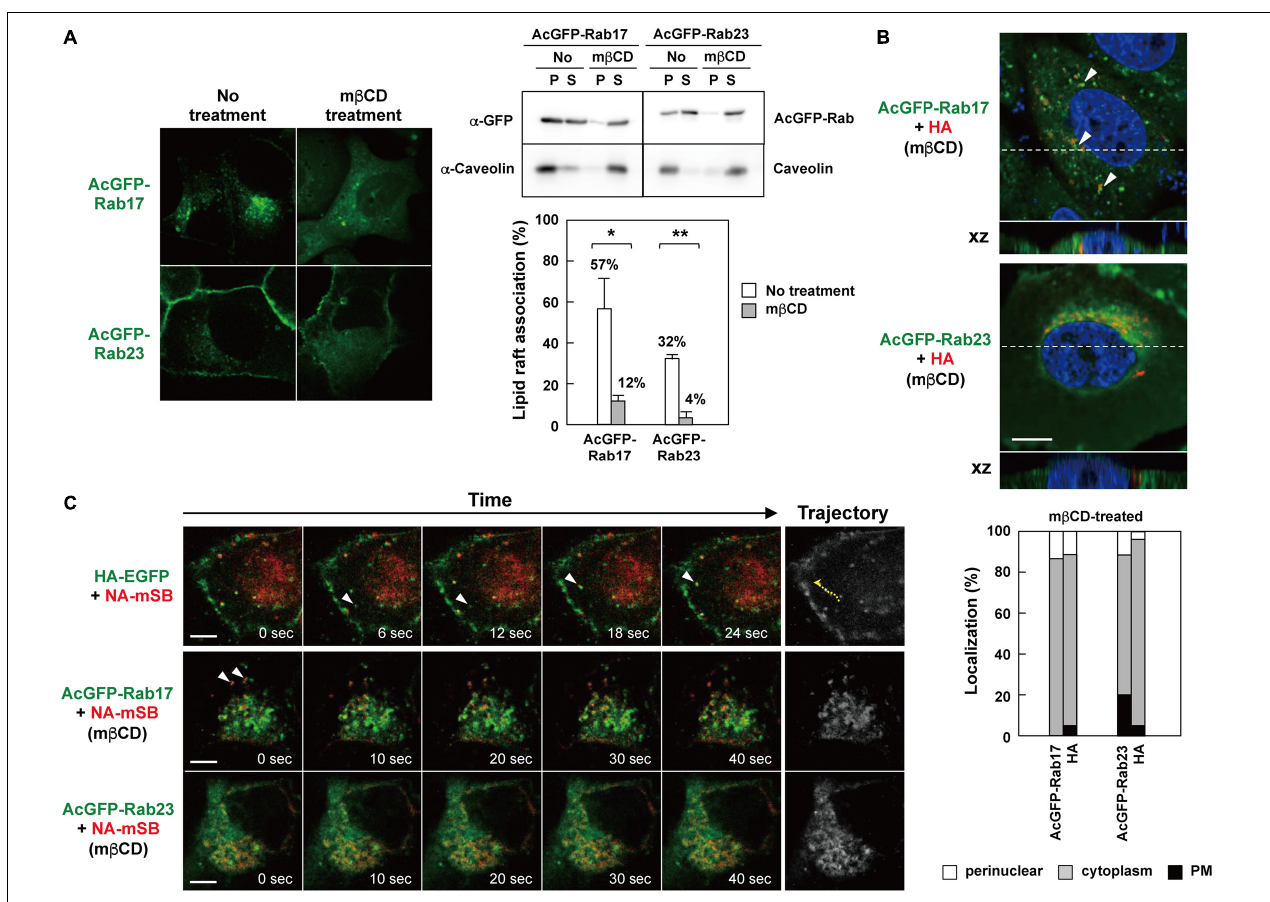
FIGURE 8 | Impaired Rab17- and Rab23-mediated trafficking of NA by cholesterol depletion. (A) Cholesterol depletion. MDCK cells stably expressing AcGFP-Rab17 and AcGFP-Rab23 were treated with 16 µ M lovastatin overnight and with additional 10 mM M β CD for 1 h. The cells were observed by confocal microscopy (left). The cells were lysed with TNE buffer containing 1% TX-100 at 4 ◦ C for 30 min, and were centrifuged at 4 ◦ C for 30 min (right). P, insoluble pellet; S, soluble supernatant. The association of AcGFP-Rab with lipid rafts was assessed by the ratio of the precipitate amount to the total amount (precipitate plus supernatant). Representative data were shown with the means and standard deviations. ∗ P < 0.05; ∗∗ P < 0.01. (B) Confocal images of HA in cholesterol-depleted AcGFP-Rab17- and AcGFP-Rab23-expressing cells. Dashed lines in xy images indicate the positions of xz images. Both images were taken at the same magnification. Scale bar, 10 µ m. Arrowheads indicate colocalization of HA and AcGFP-Rab17. For quantification of antigen localization, 20–25 cells were subjected to HA and AcGFP-Rab17/AcGFP-Rab23 distribution pattern analysis. (C) Live-cell imaging of NA-mSB in cholesterol-depleted AcGFP-Rab17-